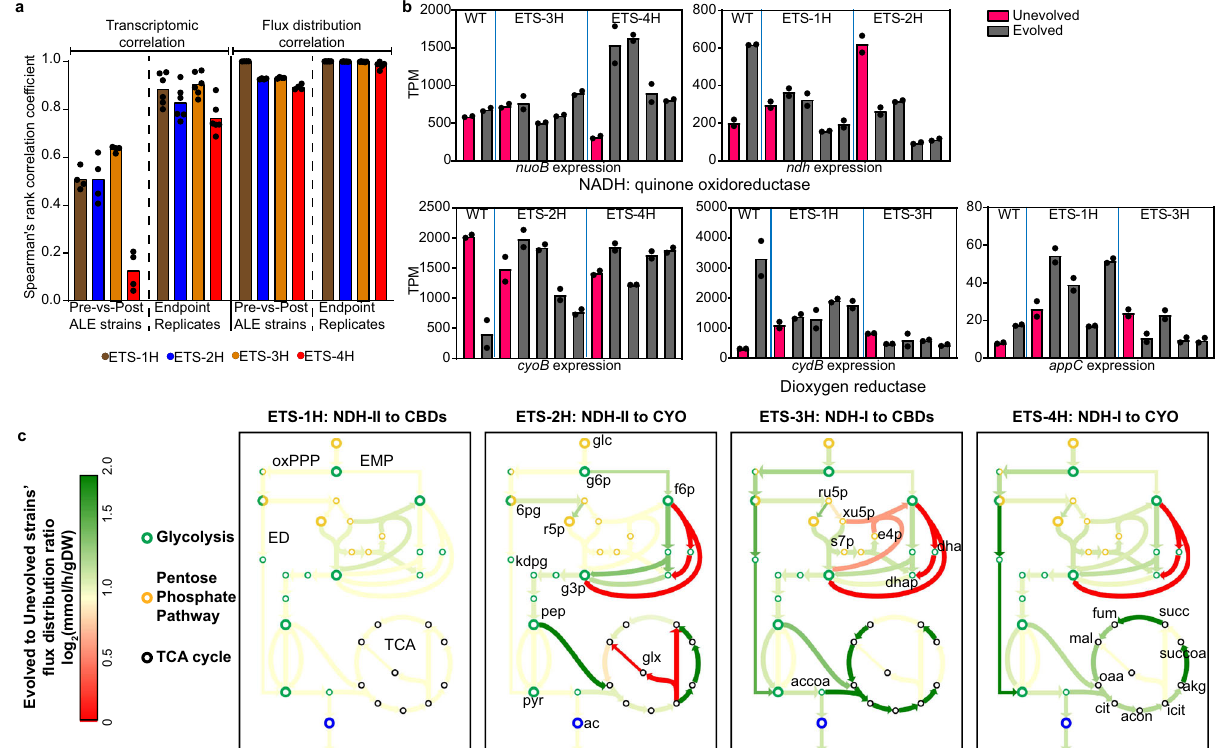
Fig. 2 Metabolic rewiring supporting growth rate optimization in the ETS variants. a Transcriptional and metabolic fl ux distribution correlations between evolved replicates and unevolved strains. Correlation of all four evolved replicates of each ETS variant has been calculated with corresponding unevolved strain and has been presented as Pre-vs.-Post ALE strains correlation. Correlation of all four evolved replicates of each ETS variant has been calculated among each other and has been presented as Endpoint Replicates correlation. b Expression changes in the alternate NqRED and O 2 RED in the unbranched ETS variants. c Computed metabolic fl ux maps depicting the central metabolism in the evolved ETS variants as compared to respective unevolved ETS variants. Key metabolites are indicated in the fi gure as follows: glc glucose, g6p D-glucose-6-phosphate, f6p D-fructose-6-phosphate, 6 pg